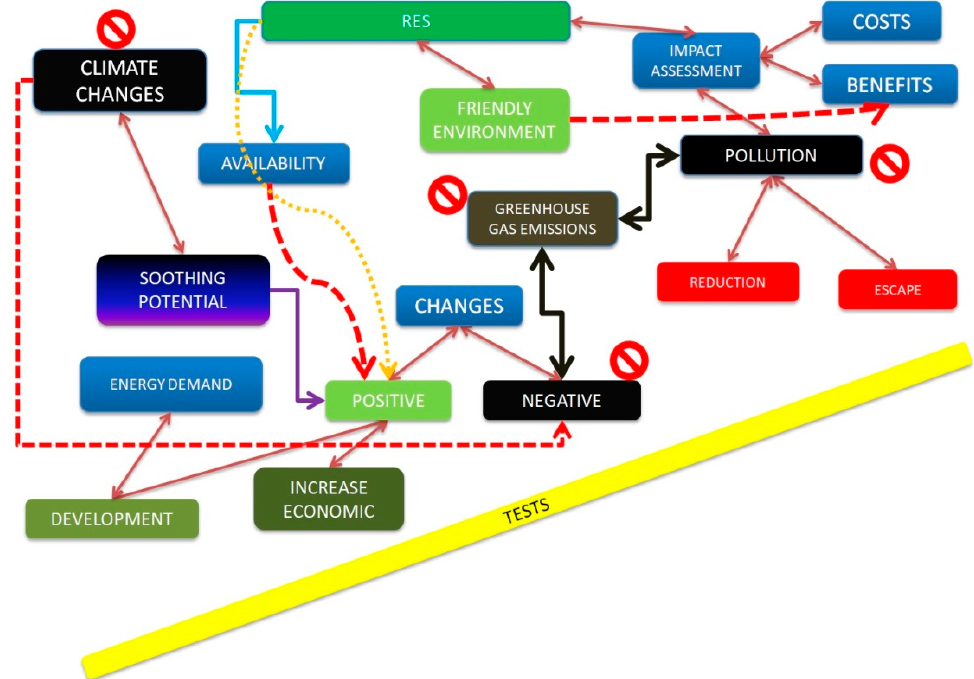
Figure 19. Threshold assumptions shaping the development of renewable energy in the international environment. Source: own study.